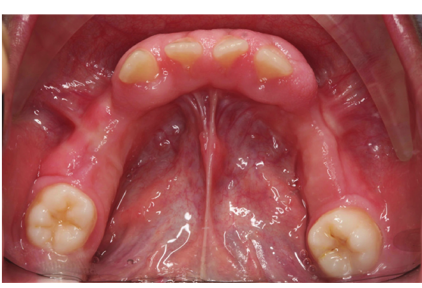
Figure 6: Lower occlusal view.